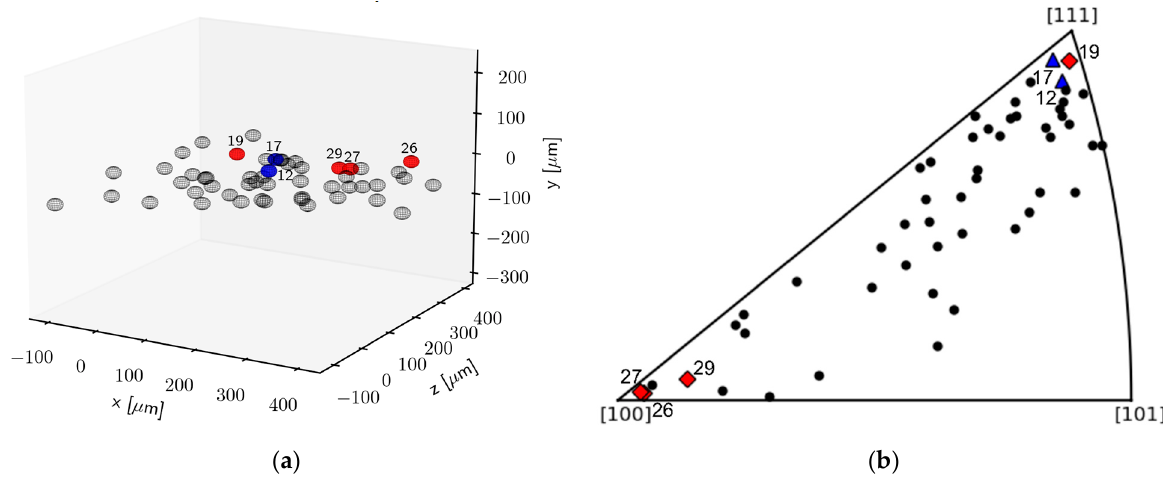
Figure 3. ( a ) Center of mass at 0.09 strain and ( b ) grain orientations in an inverse pole figure plot at 0.09 nominal strain. Red markers indicate grains which formed predominantly stacking faults, and blue markers represent grains in which the formation of dislocations was predominant.